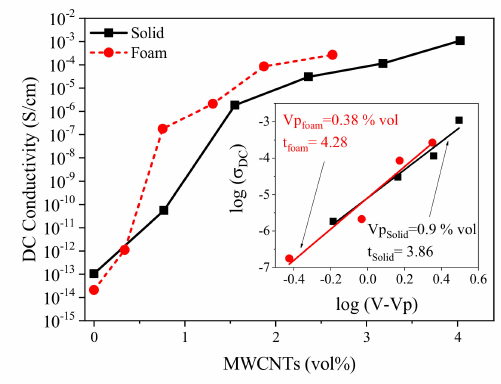
Figure 4. DC electrical conductivity of solid and foamed nanocomposites as a function of filler content. The inset shows the log–log plot of DC conductivity versus (V − V p